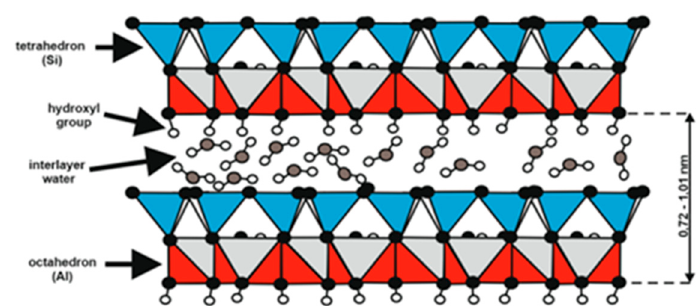
Figure 6. X-ray diffraction (XRD) patterns of raw halloysite and dried halloysite from the Dunino deposit.